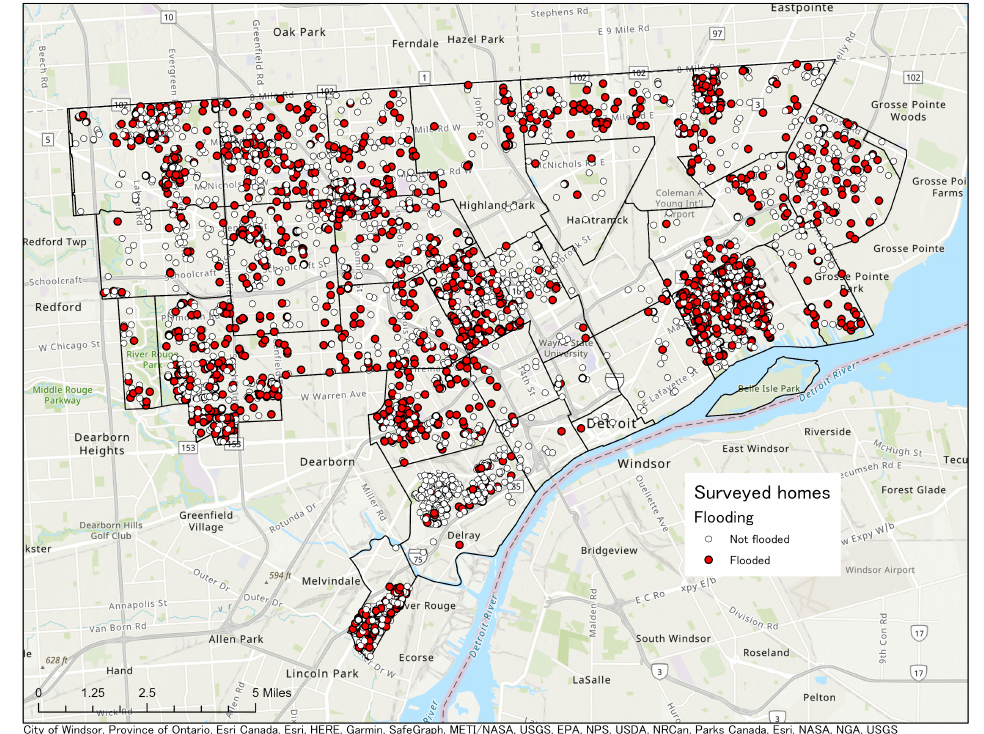
Figure 2. Locations of households which reported that they experienced pluvial flooding. Households that responded that no flooding occurred are not